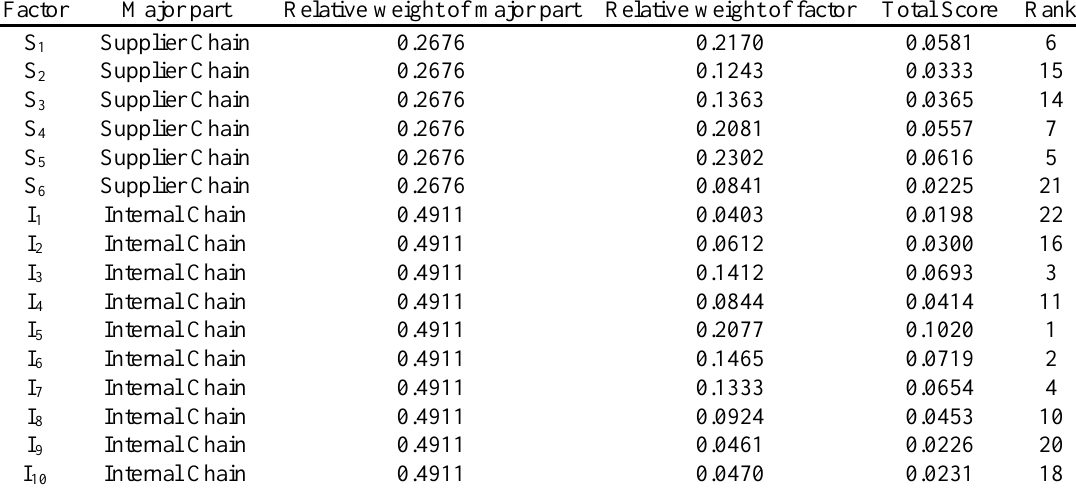
Table 15. Aggregated results for each factors according to each part of the supply